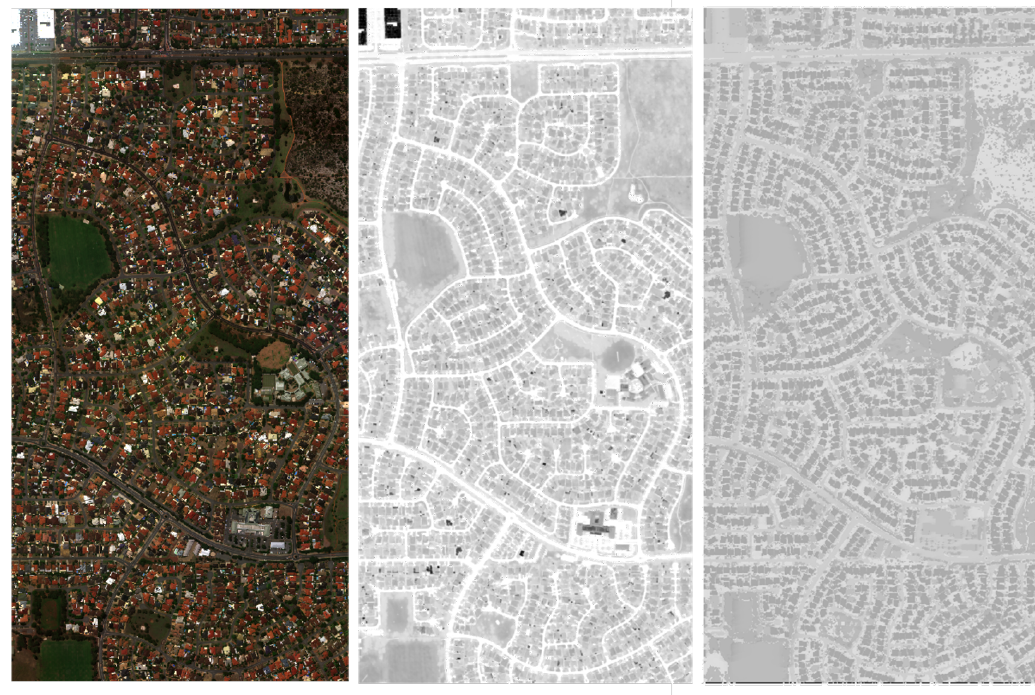
Figure 2. Orthophoto (left), measured (middle) and simulated temperatures (right) in white-hot representation.